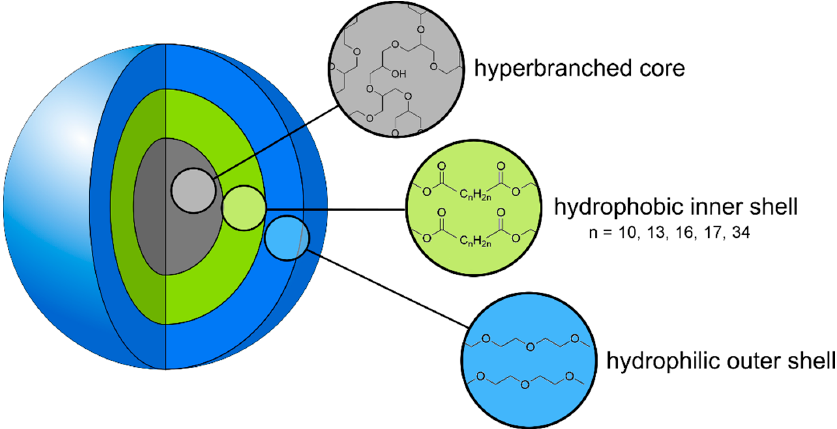
Figure 1. Structure of an ester-based CMS nanocarrier.